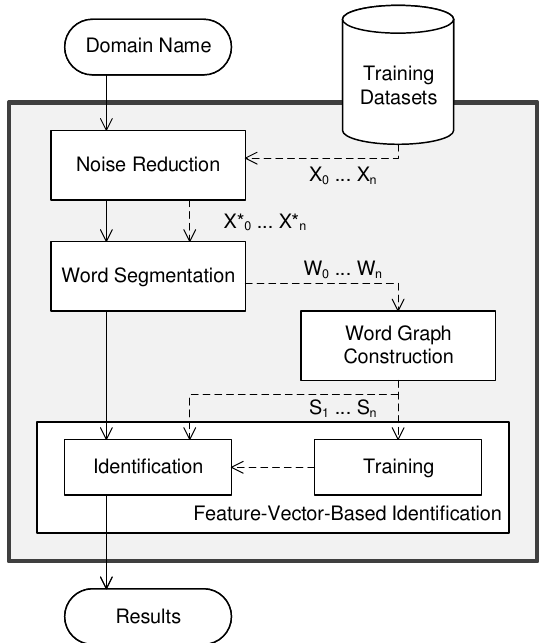
Figure 2. Overview of our proposed approach for identifying malicious domain names by analyzing their character strings at the word